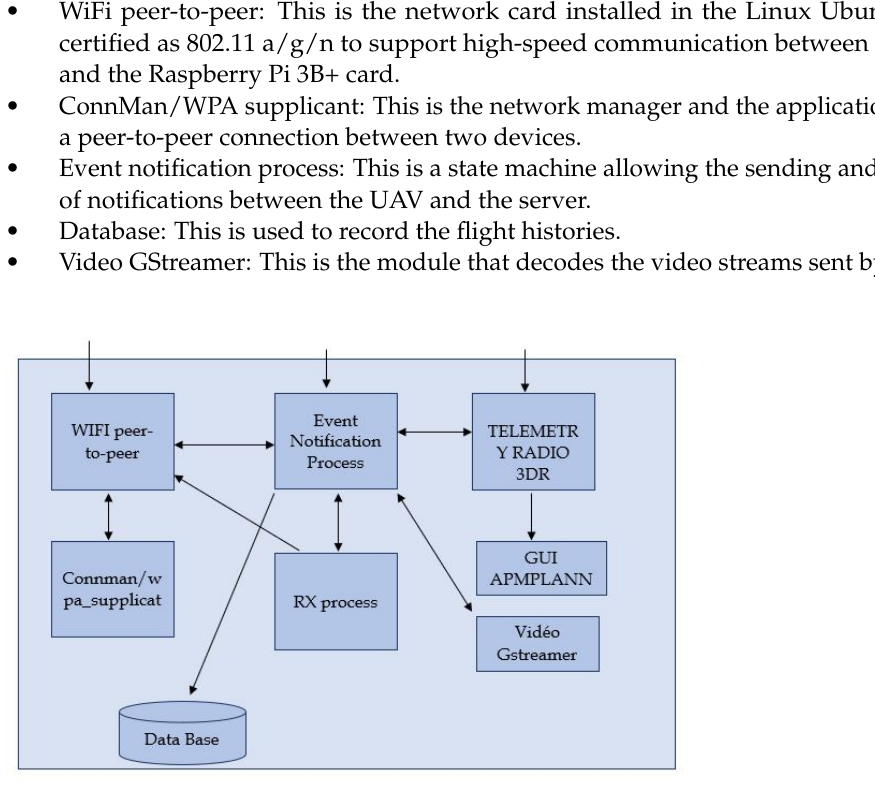
Figure 4. The server